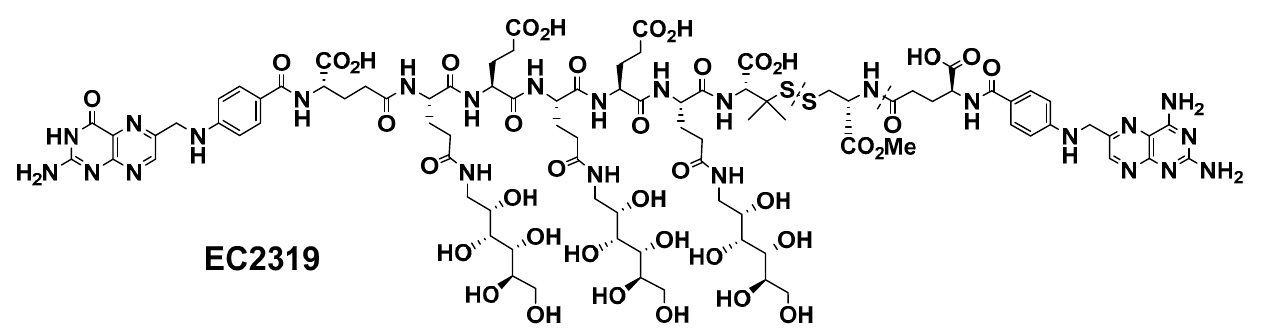
Figure 1. EC2319 chemical structure.